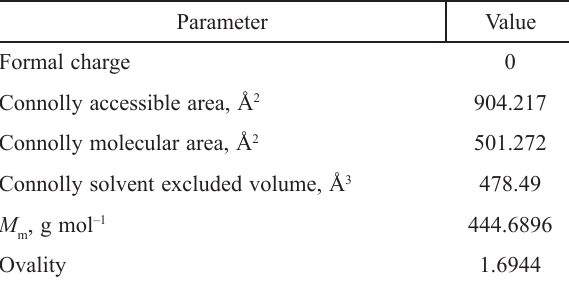
Table 4 – Molecular characteristics of vitamin E